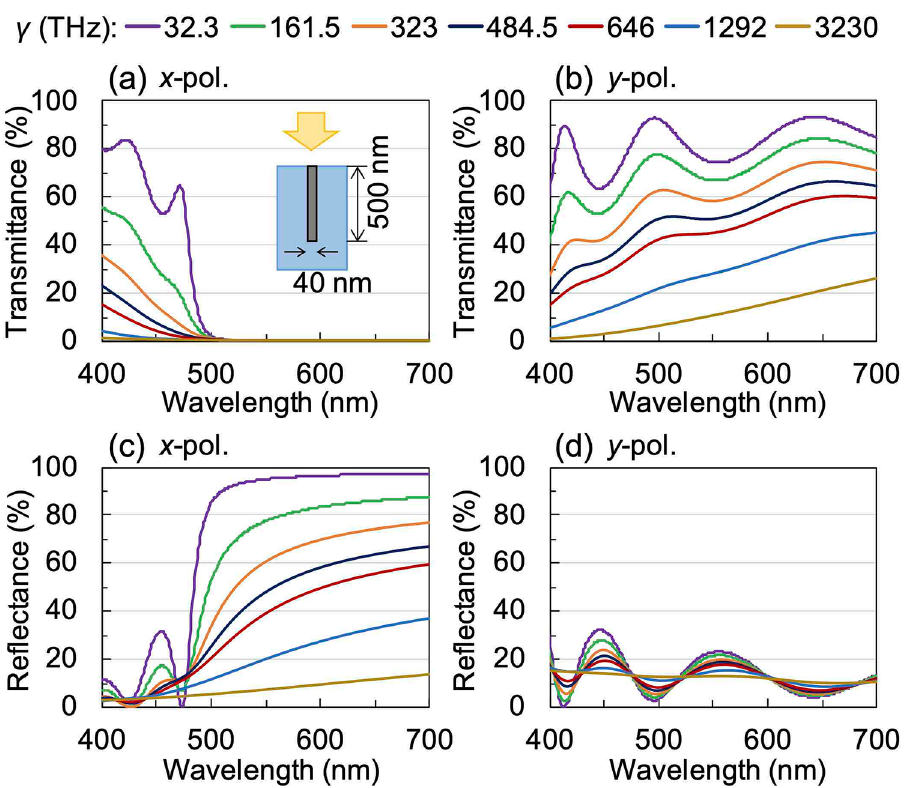
Figure 2. Calculated ( a ), ( b ) transmittance and ( c ), ( d ) reflectance spectra of embedded WGP sheet as a function of damping or collision frequency γ . The polarisation directions are ( a ), ( c ) x -polarisation and ( b ), ( d ) y